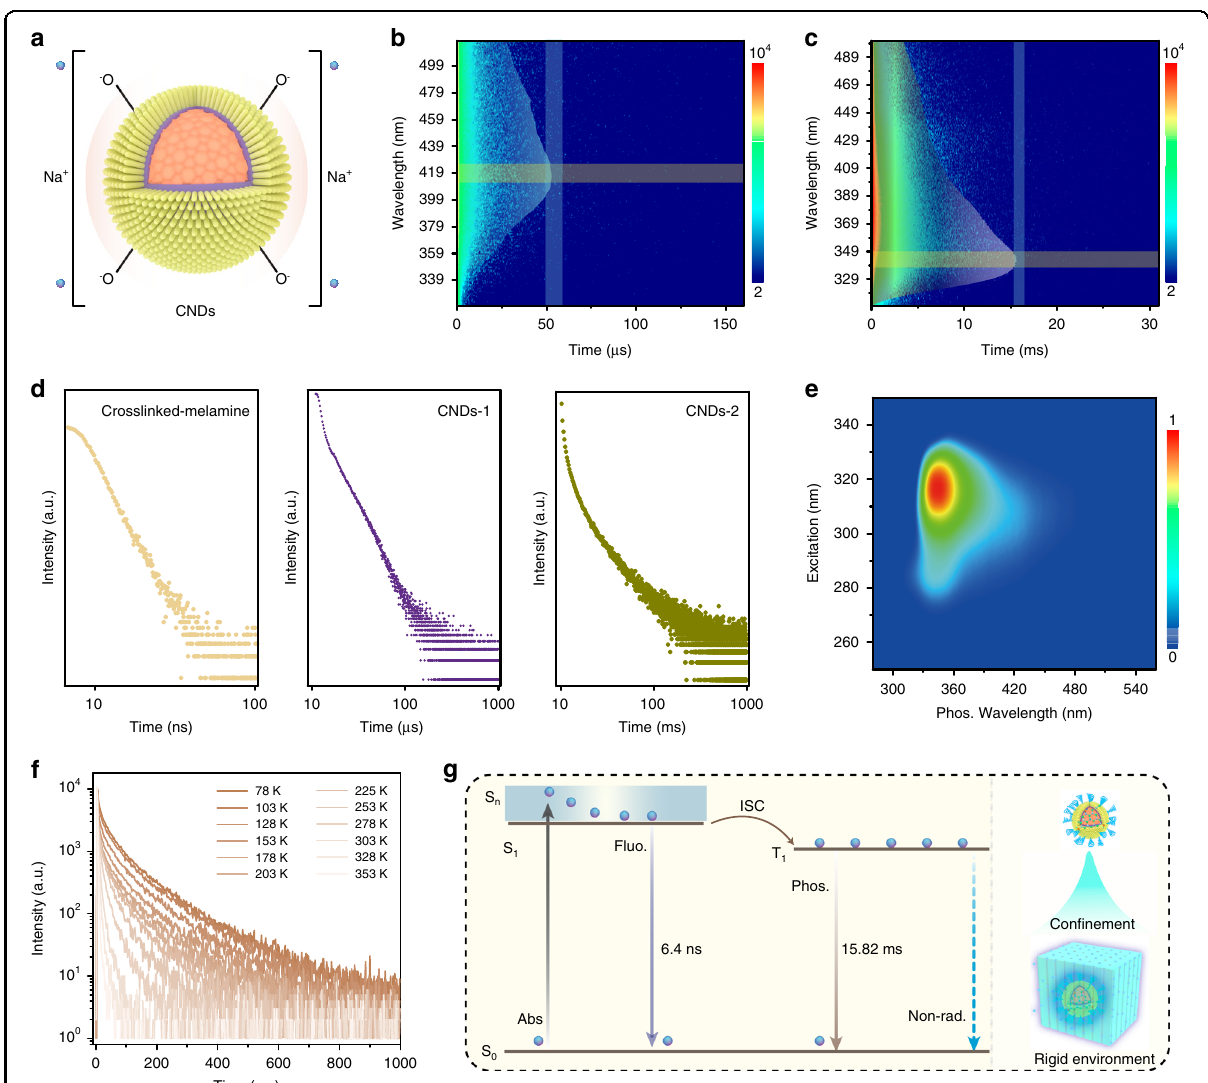
Fig. 3 Phosphorescence characterization and a proposed UV phosphorescence mechanism. a Schematic diagram of CND con fi nement through ionic bonding. b Time-resolved spectra of CNDs-1@NaCNO and ( c ) CNDs-2@NaCNO. d Emission lifetime decay curves of crosslinked melamine@Na 2 CO 3 (collected at 430 nm), CNDs-1@NaCNO (collected at 415 nm), and CNDs-2@NaCNO (collected at 348 nm). e Excitation- phosphorescence counterplots of CNDs-2@NaCNO. f Temperature-dependent emission decay plots of CNDs-2@NaCNO recorded at 348 nm. g A transition model of the UV phosphorescent